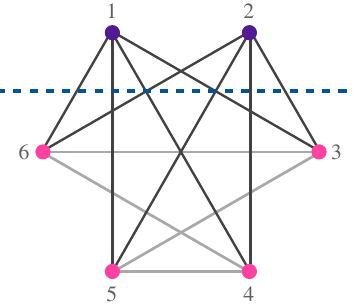
FIG. 4. The max-cut problem for a graph is to find a cut, i.e., a bipartition, such that the number of edges that cross the cut is maximized. For the graph shown in the figure, the max-cut is 8 (achieved by the cut 1, 2 versus 3, 4, 5, 6), which matches our SDP relaxation ξ 2 = 8, while the usual Goemans-Williamson method gives only the upper bound ξ 1 =